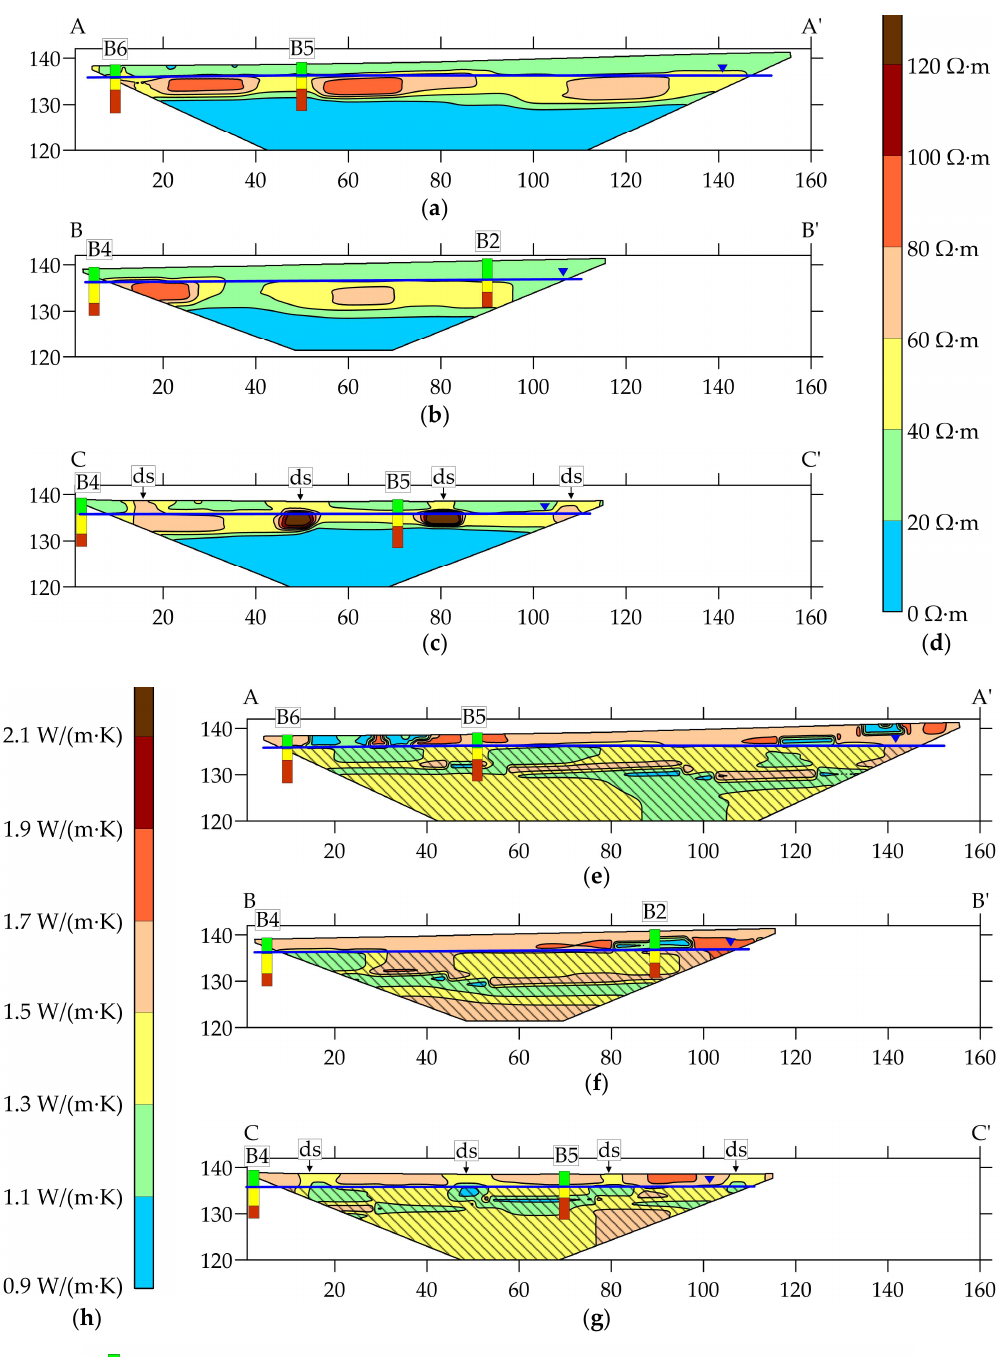
Figure 6. ( a – d ) Distribution of electrical resistivities in the subsurface along the ERT sections with colour scale; ( e – h ) derived thermal conductivities for each ERT section with colour scale. The derivation method is only applicable to the unsaturated zone (area that is not hatched). Shown also are simplified profiles of boreholes crossed by ERT sections and groundwater level from 7 April 2021, legend is shown in ( i ). In addition, the location of distribution shafts (ds) is shown in Section C. Altitudes are given in meters above sea level, length in